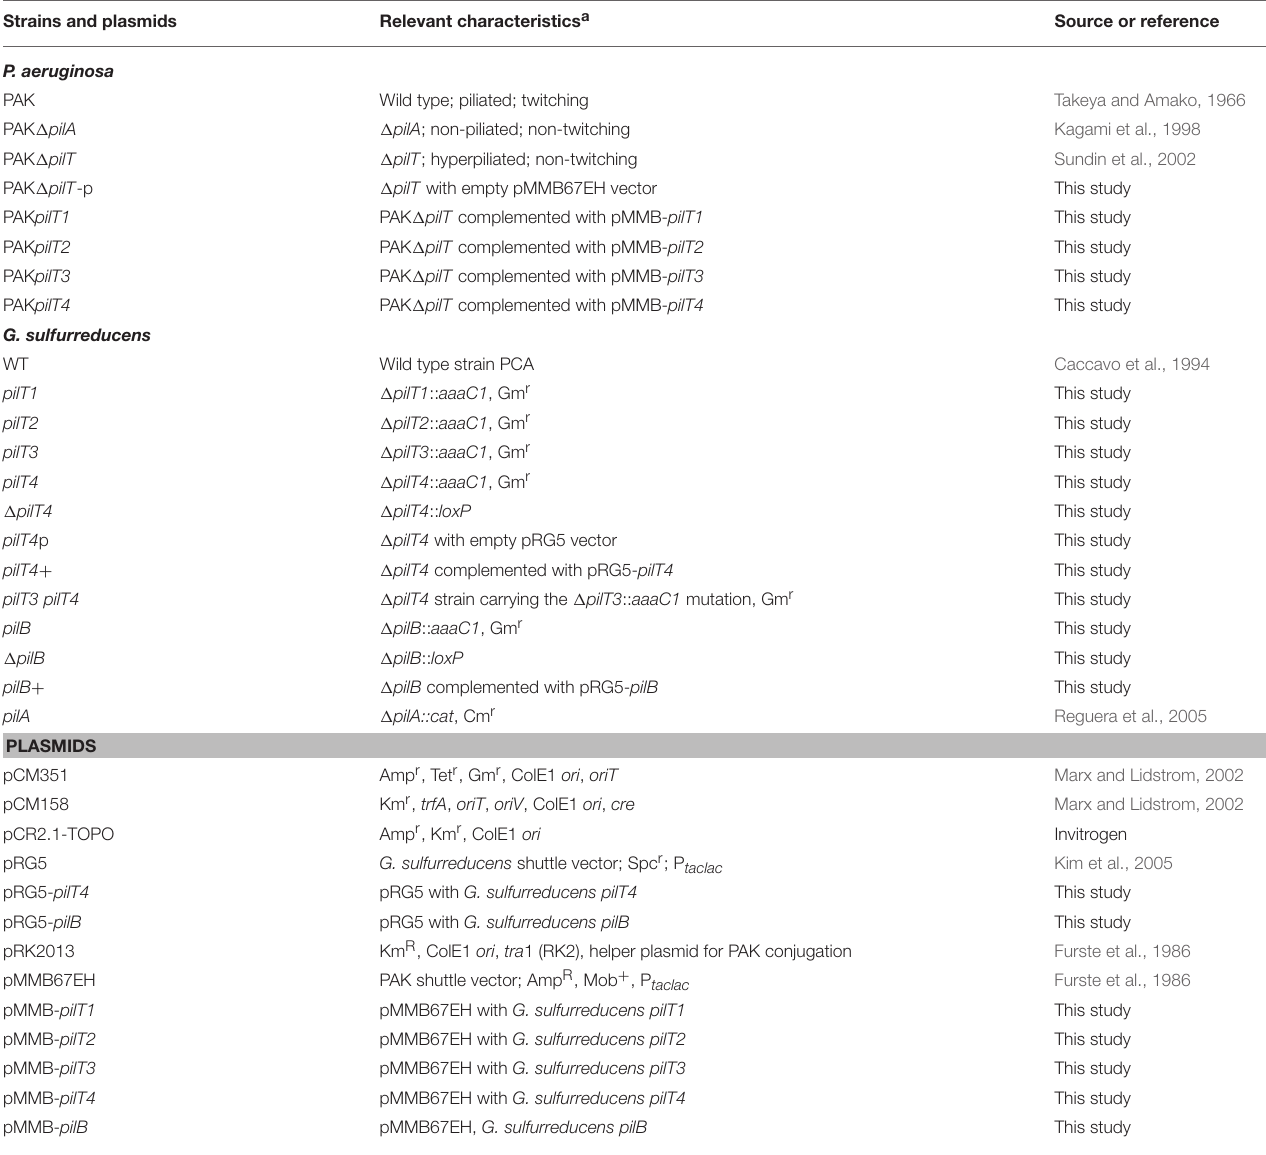
TABLE 1 | Strains and plasmids